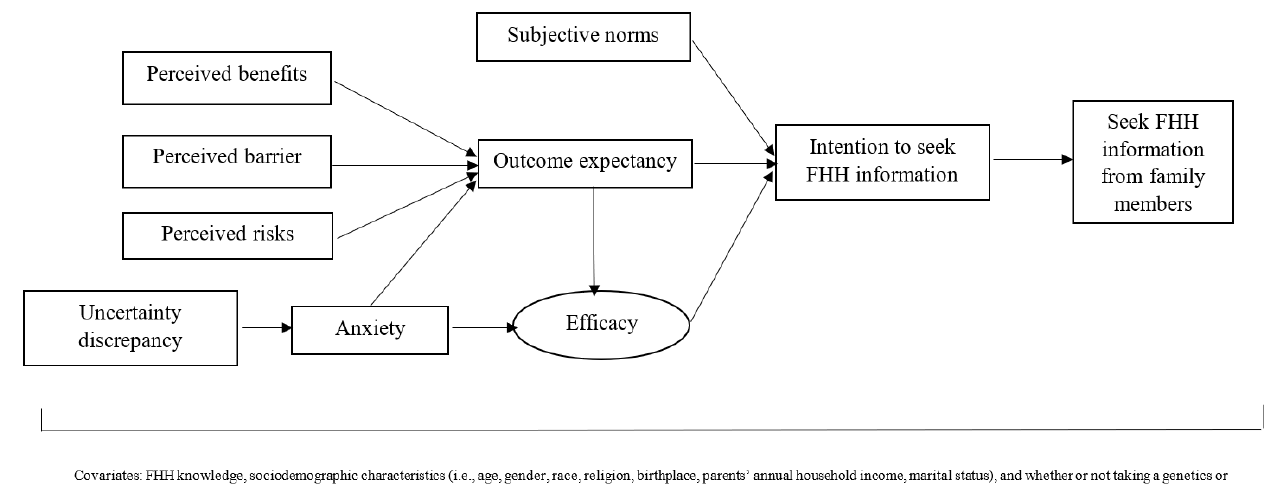
Figure 1. Proposed integrated theoretical model of FHH information seeking behavior among young adults . FHH: family health history.